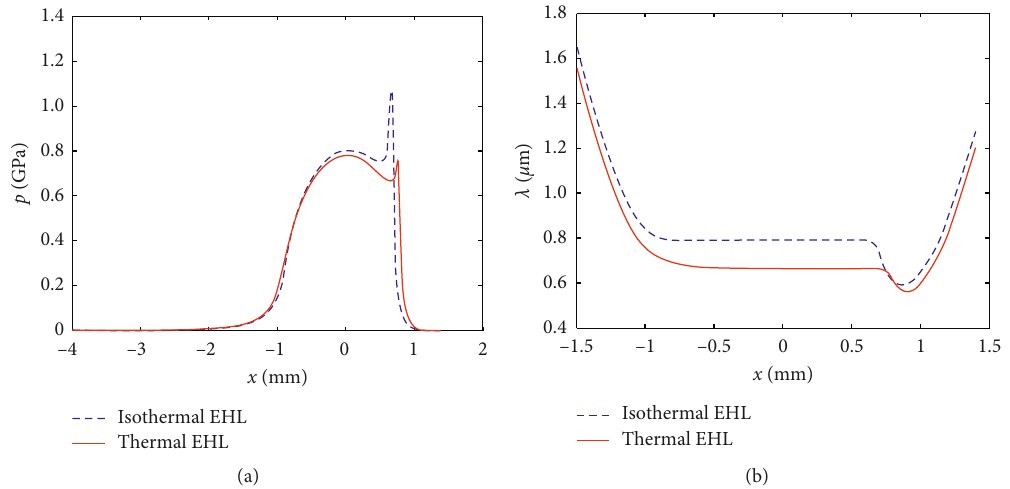
Figure 14: Comparison of the results under isothermal and thermal EHL lubrication: (a) film pressure; (b) film thickness